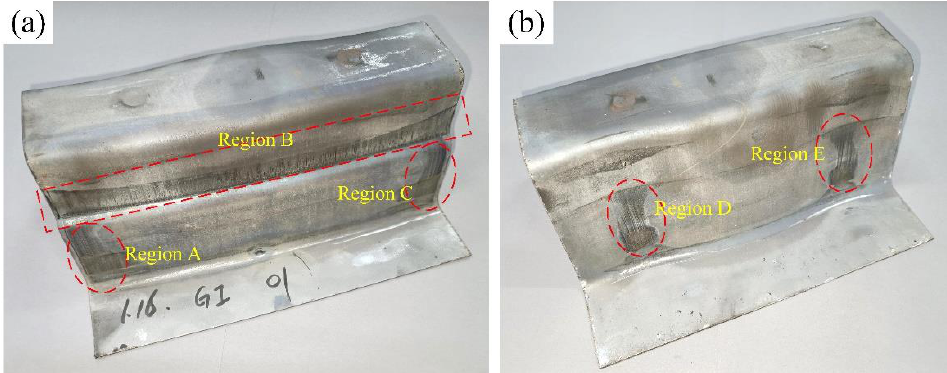
Figure 7. The photos of GI coated sample: ( a ) the stepped wall of sample; ( b ) the smooth wall of the sample.